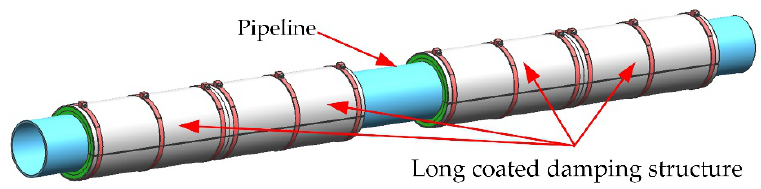
Figure 2. Scheme of segmented long coated damping structure.